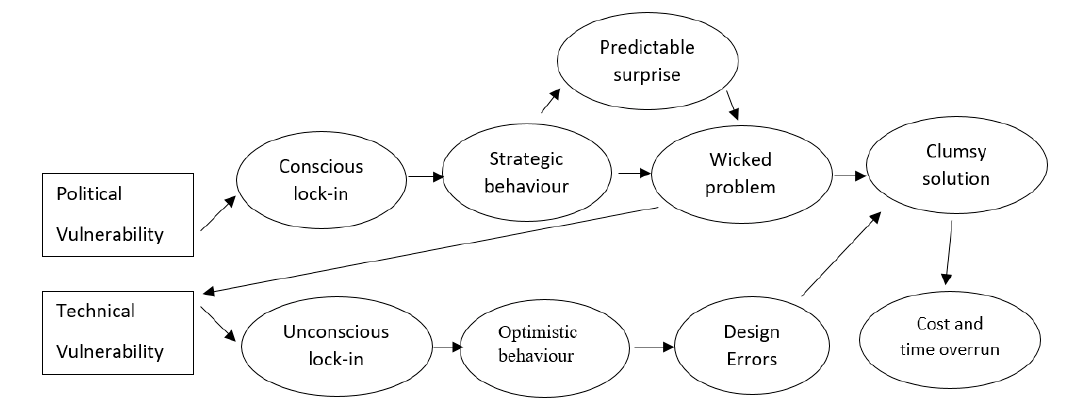
Figure 4. Inefficient decision-making pathway throughout the project life cycle based on the lock-in concept.